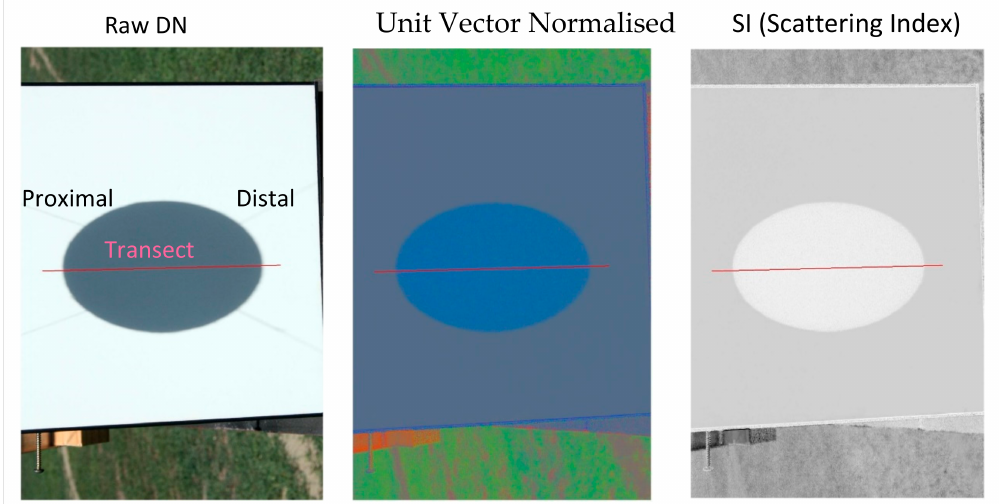
Figure 10. Canon 450D images for the 50 ◦ zenith showing transect location and proximal–distal parts of shadows for the raw DN image, unit vector normalised image, and the SI (scattering index) image. Images have been rotated 90 ◦ anticlockwise to show transects